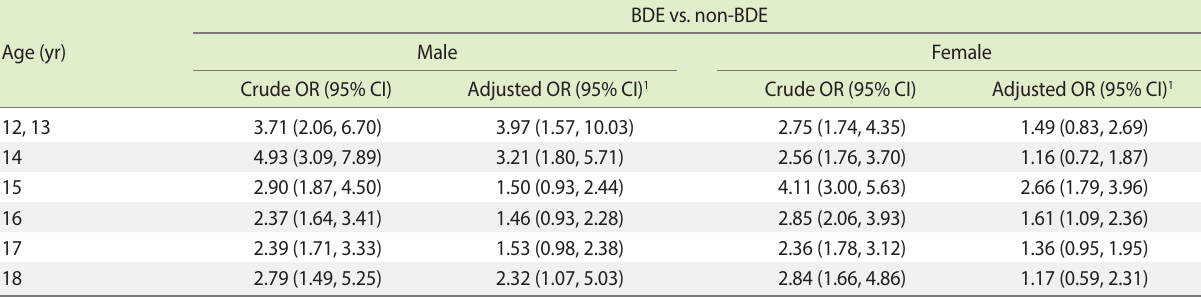
Table 5. Relationship between binge drinking experience (BDE) and suicide attempts, by age